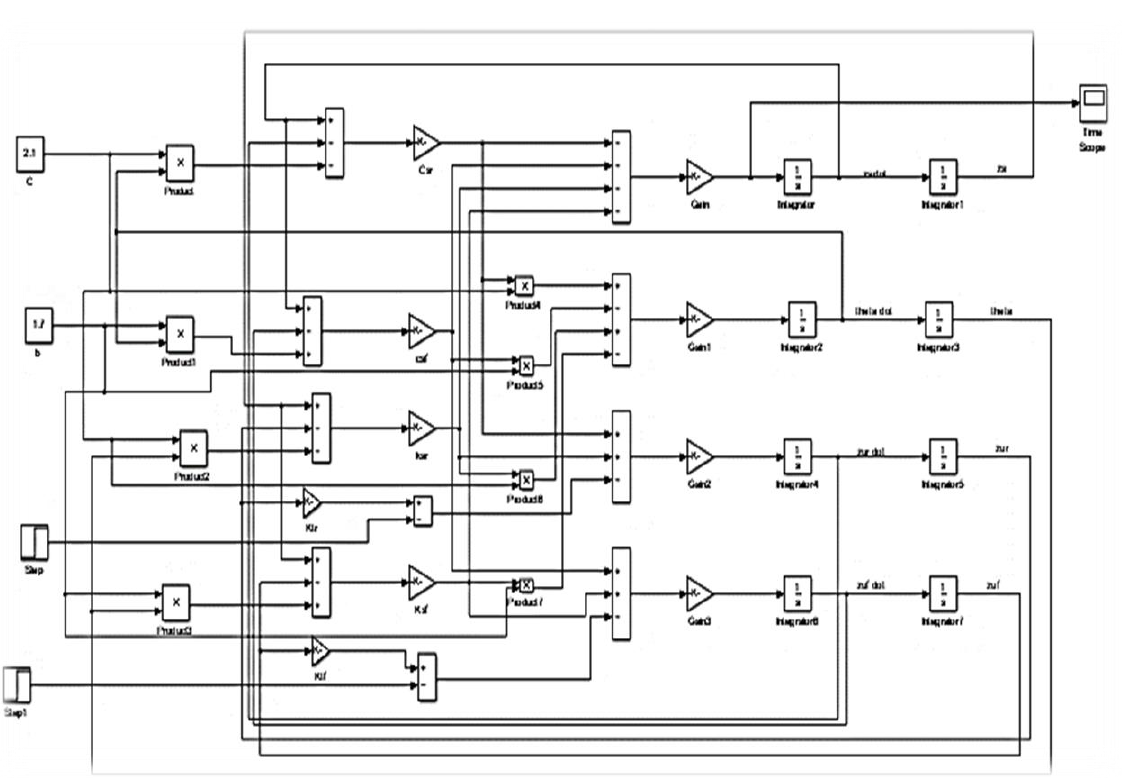
Figure 9. Simulink block diagram for half car